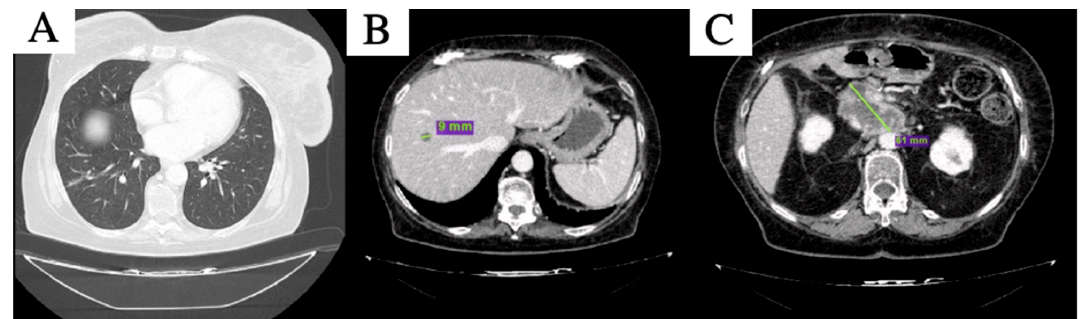
Figure 3. CT scan after 4 months of olaparib: complete disappearance of the nodular lesioni in inferior lobe of the right lung was confirmed ( A ), the hepatic lesion in the 8th segment ( B ) is further reduced in size and peripancreatic tissue is slightly increased and substancial stability of the peripancreatic tissue was described ( C ).